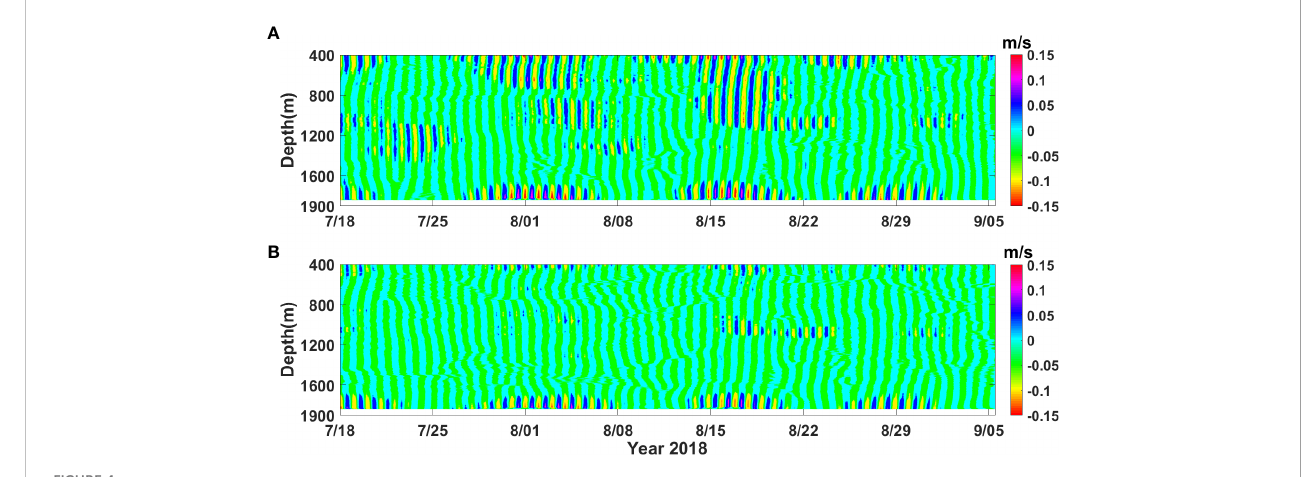
FIGURE 4 (A) Time-depth map of band-pass fi ltered diurnal velocities (along-slope component). (B) High-mode ( n ≥ 4) diurnal